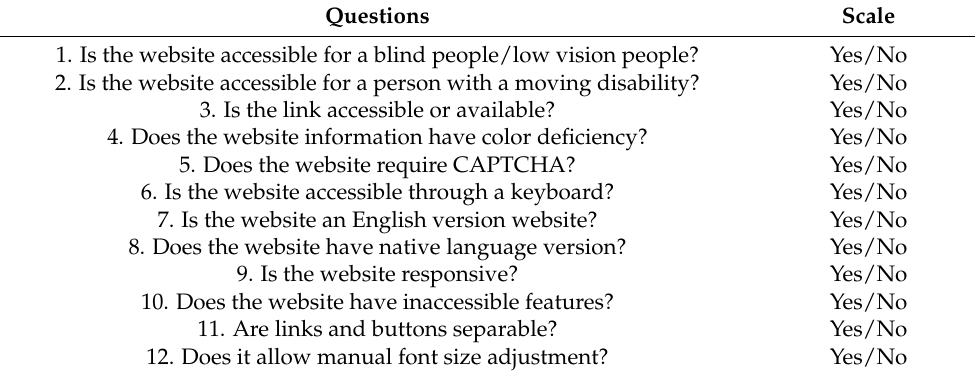
Table 4. Expert testing questionnaire with evaluation scale.